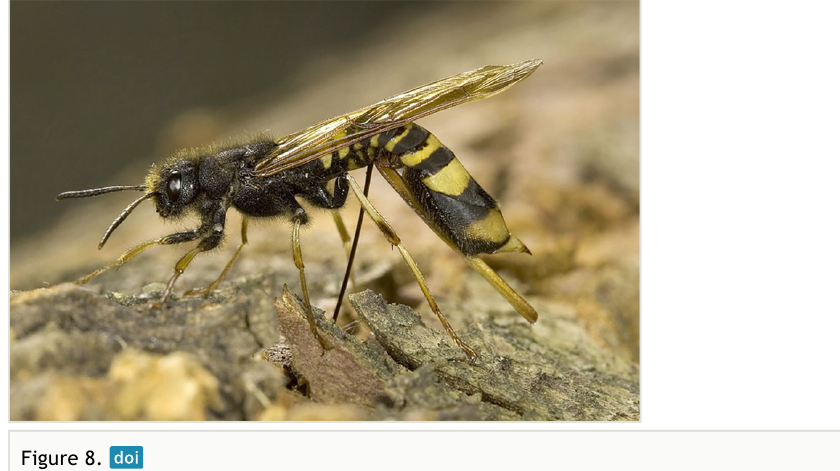
Diprionidae: Rather small and mainly Holarctic family. The larvae live (often gregariously) on conifers, and may become a serious pest. Adult males of several species have conspicuously branched antennae. Cephidae: Rather small and mainly Holarctic family. The larvae bore in twigs of deciduous trees and shrubs or in stems of Gramineae (Poaceae). Siricidae: Rather small and mainly Holarctic family, but introduced with timber into other areas. The larvae bore in wood of coniferous and deciduous trees and shrubs, stems of Gramineae (Poaceae), or sometimes in herbs." (e.g. Pachycephus in Papaver). Adults have their wings more or less longitudinally wrinkled (Fig. 8).